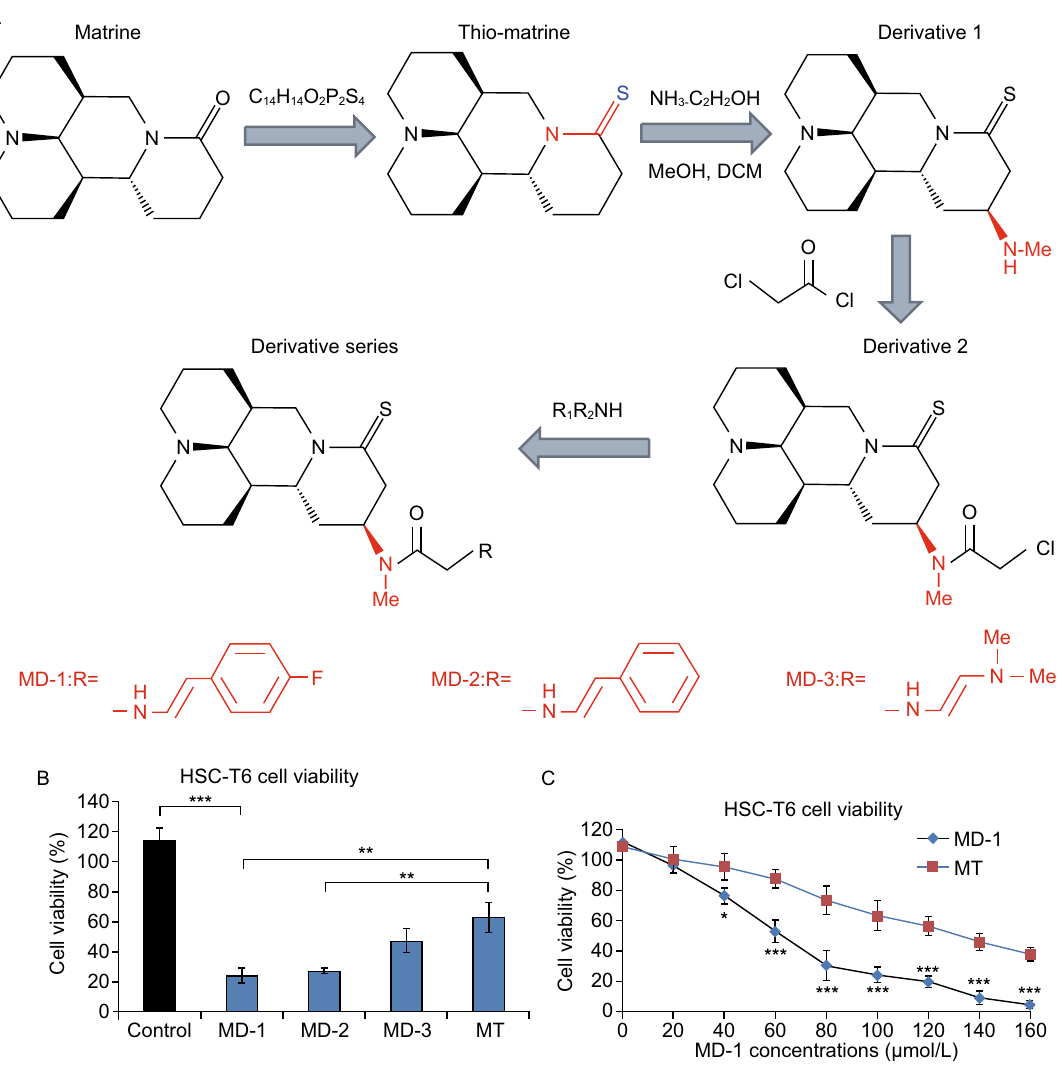
Figure 1. Novel thio derivatives of MT inhibit the proliferation of HSC-T6 cells. (A) The chemical structure of MD-1, MD-2, and MD-3. (B) The inhibitory effects of MD-1, MD-2, and MD-3 on the proliferation of HSC-T6 cells (MD-1 group: 24.2% ± 5.0%; MD-2 group: 27.4% ± 1.6%; MD-3 group: 47.2% ± 8.1%; MT group: 62.9% ± 10.0%; control group: 114.2% ± 8.5%; n = 3 in each group). (C) A concentration-dependent plot of the effect of MD-1 and MT on the proliferation of HSC-T6 cells. IC 50 of MD-1 and MT was 62 µmol/L and 128 µmol/L,